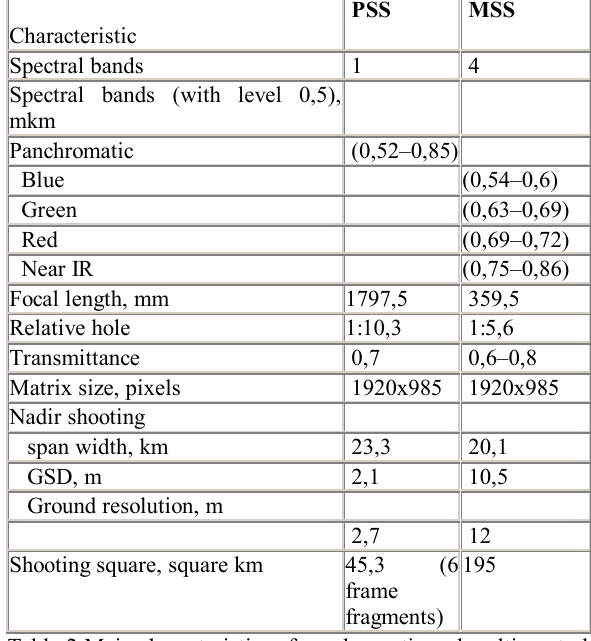
Table 2 Main characteristics of panchromatic and multispectral sensors.